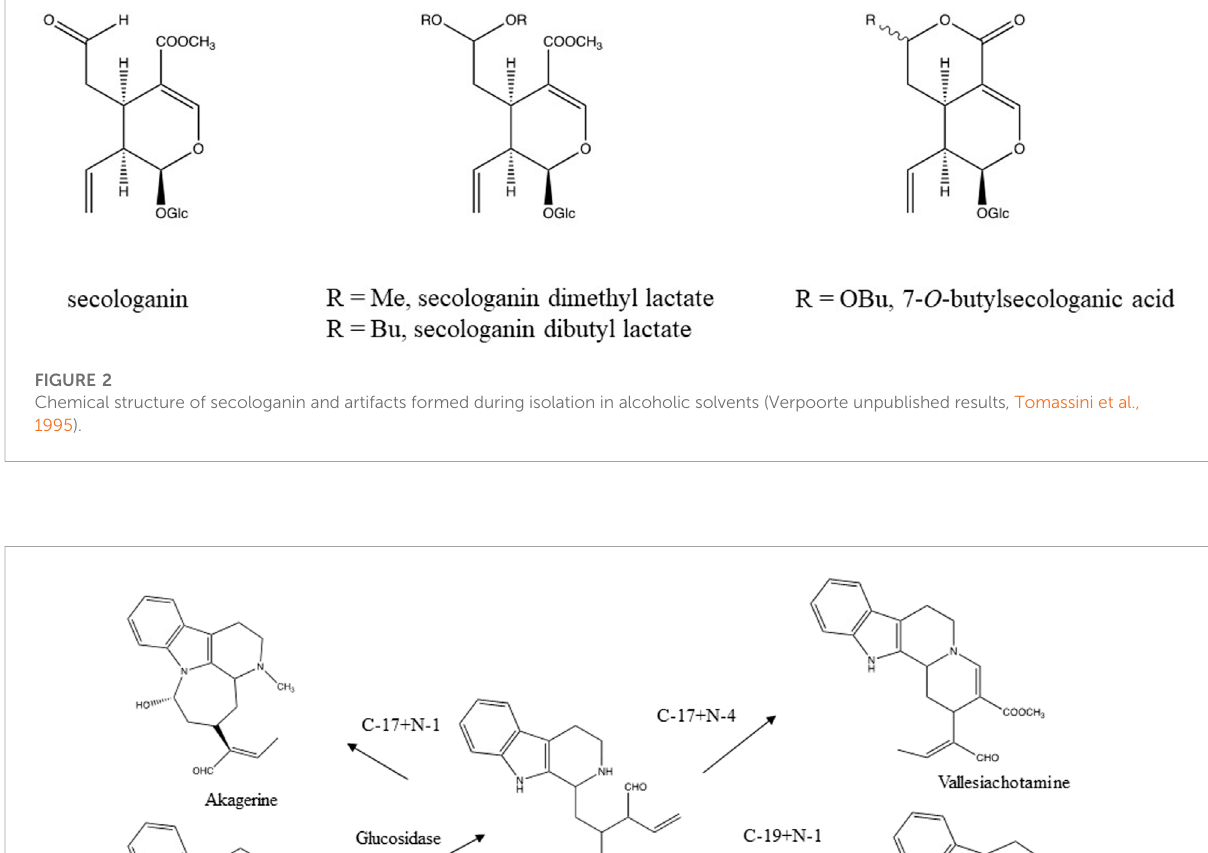
detail by Xu and coworkers (2020). They developed a chemometric tool to predict potential artifacts by reactions with methanol or oxidation. Some benzylisoquinoline